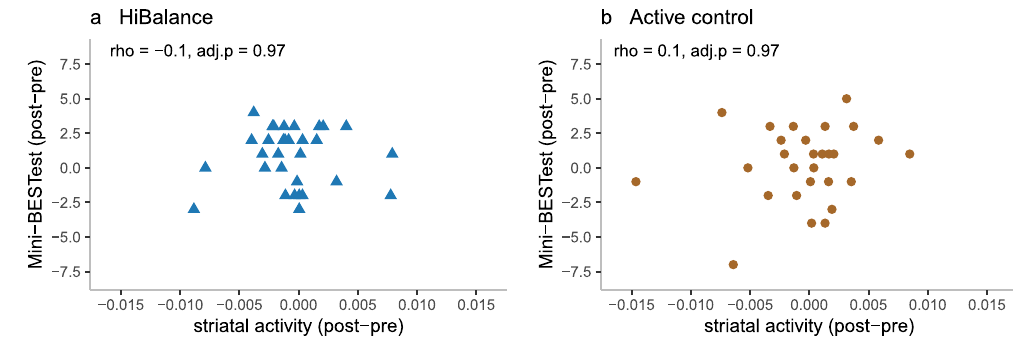
Fig. 3 The difference score correlations of the Mini-BESTest and striatal activity. rho = Spearman ’ s rank-order correlation coef fi cient. adj. p = false discovery rate adjusted p (alpha = 0.05). a The difference score correlations in the HiBalance group. b The difference score correlations in the active control